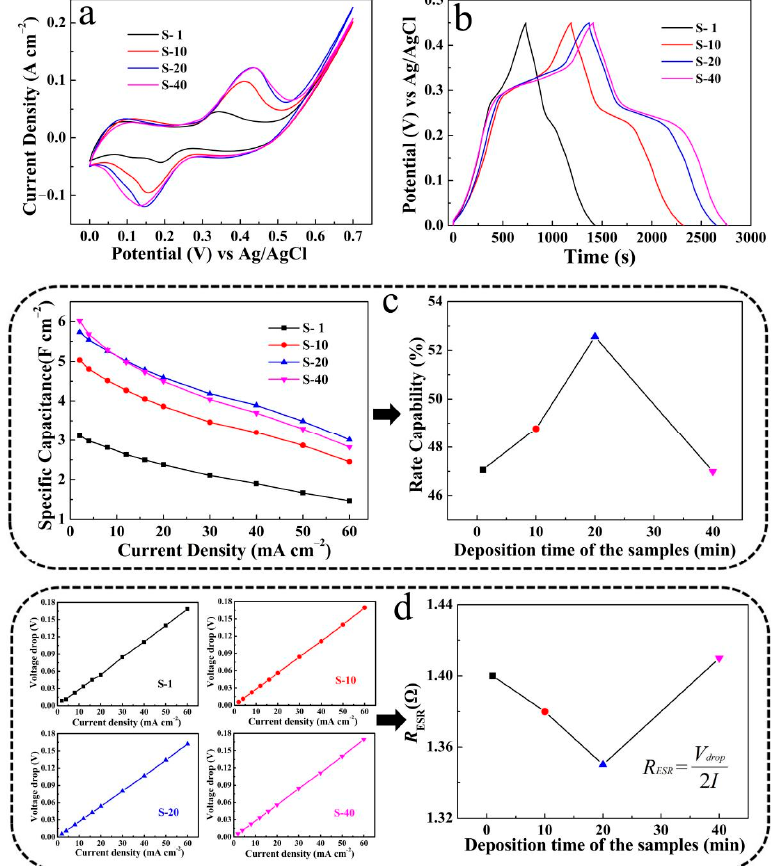
Figure 6. Performance comparison of S-1, S-10, S-20 and S-40: ( a ) CV curves, ( b ) GCD curves, ( c ) C s at different current densities and corresponding rate capabilities and ( d ) voltage drops at different current densities and corresponding average R ESR .